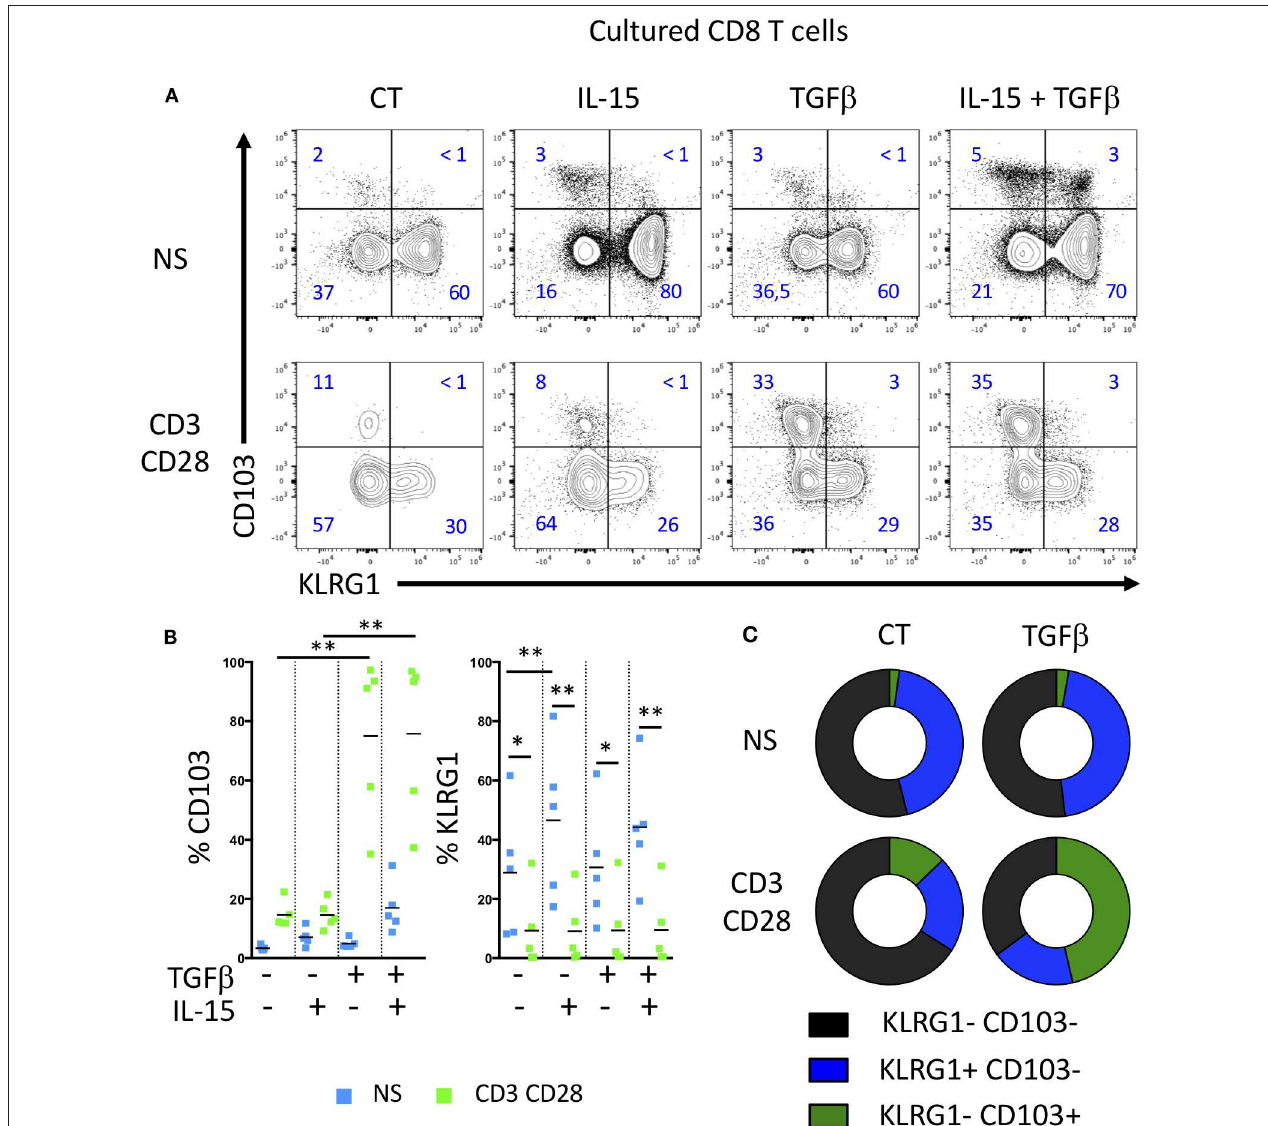
FIGURE 2 | TGF β and TCR triggering highly induces CD103 expression on T cells, but decrease KLRG1 expression. (A) Representative expression of CD103 and KLRG1 on CD8T cells following IL-15 and TGF β incubation and TCR stimulation during 7 days. (B) Quantification and (C) proportion of CD103 and KLRG1 expression on CD8T cells (dots and bars represent 5 independent experiments with mean; ANOVA with Bonferoni post-test:* p < 0.05, ** p <